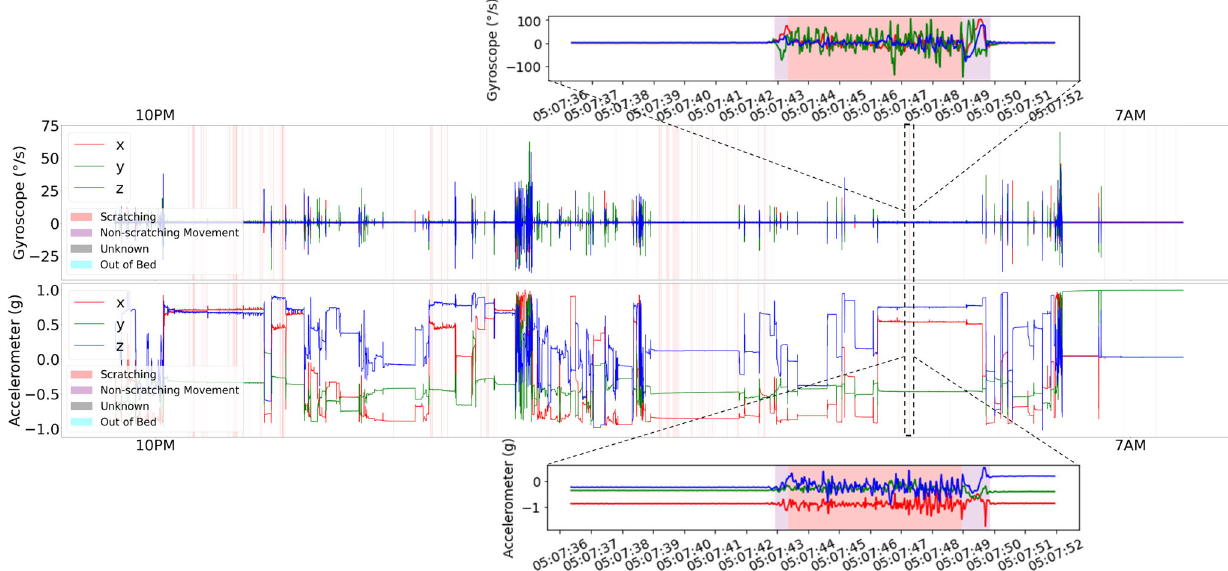
Fig. 6 Overlaid actigraphy data and video annotations. Plots detailing one subject night of actigraphy data overlaid with video annotation after timestamp alignment. Note: Slight differences between the video annotation of the accelerometer and gyroscope plots are due to